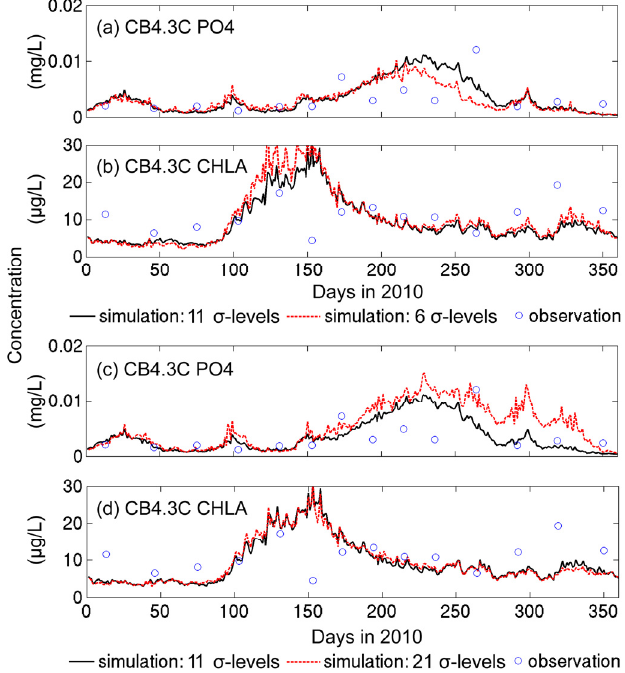
Figure 6. Time series of observed (open dots) and simulated (black solid line, results of 11 sigma levels; black dash line, results of six ( a , b ) or 21 ( c , d ) sigma levels) phosphate ( a , c ) and CHLA ( b , d ) at Station CB4.3C in Chesapeake Bay (Figure 1) in 2010.